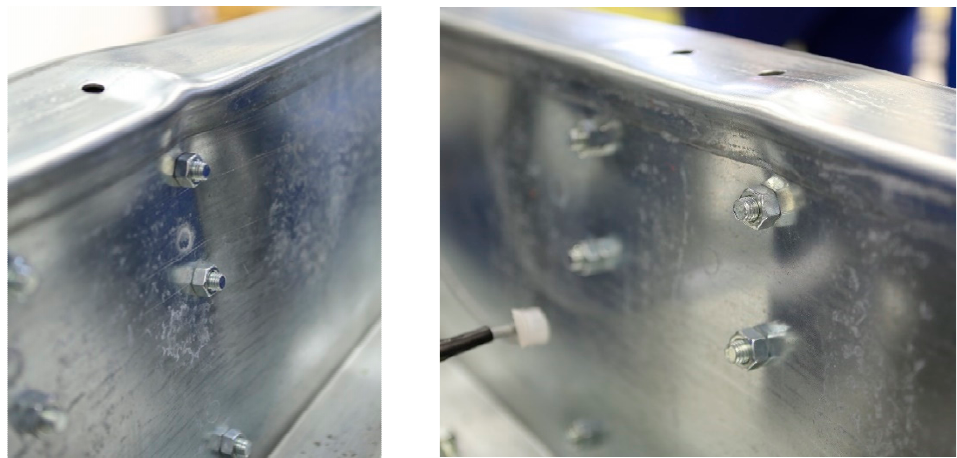
Figure 7. Photos of local buckling of the pressed part of the cross section with a clip.